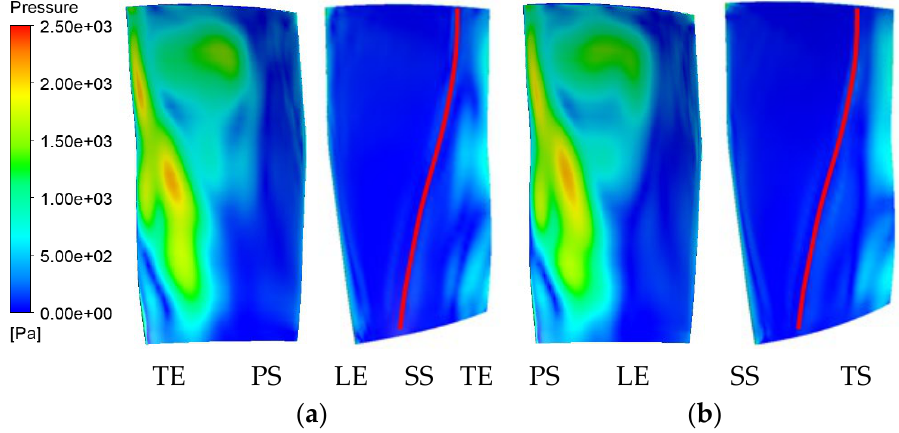
Figure 25. 45 EO amplitude of static pressure on the surface of R1 rotor blade (red line is shock wave). ( a ) C# ( b ) M#. ( a ) C# ( b ) M#.